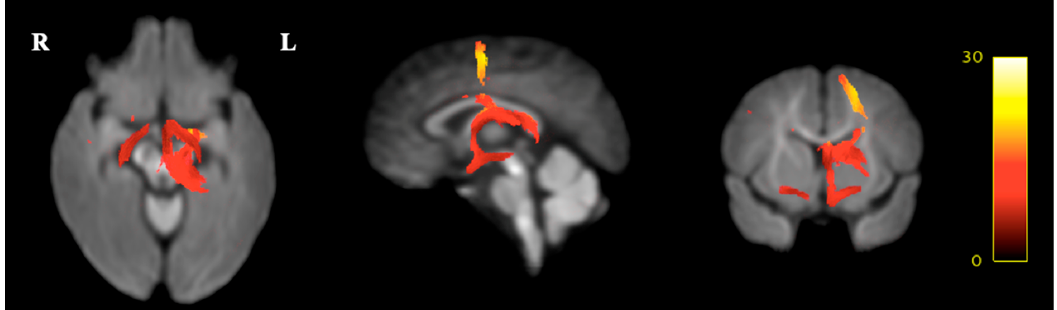
Figure 6. Presentation of the FBA results expressing the effect sizes as a relative increase (from red